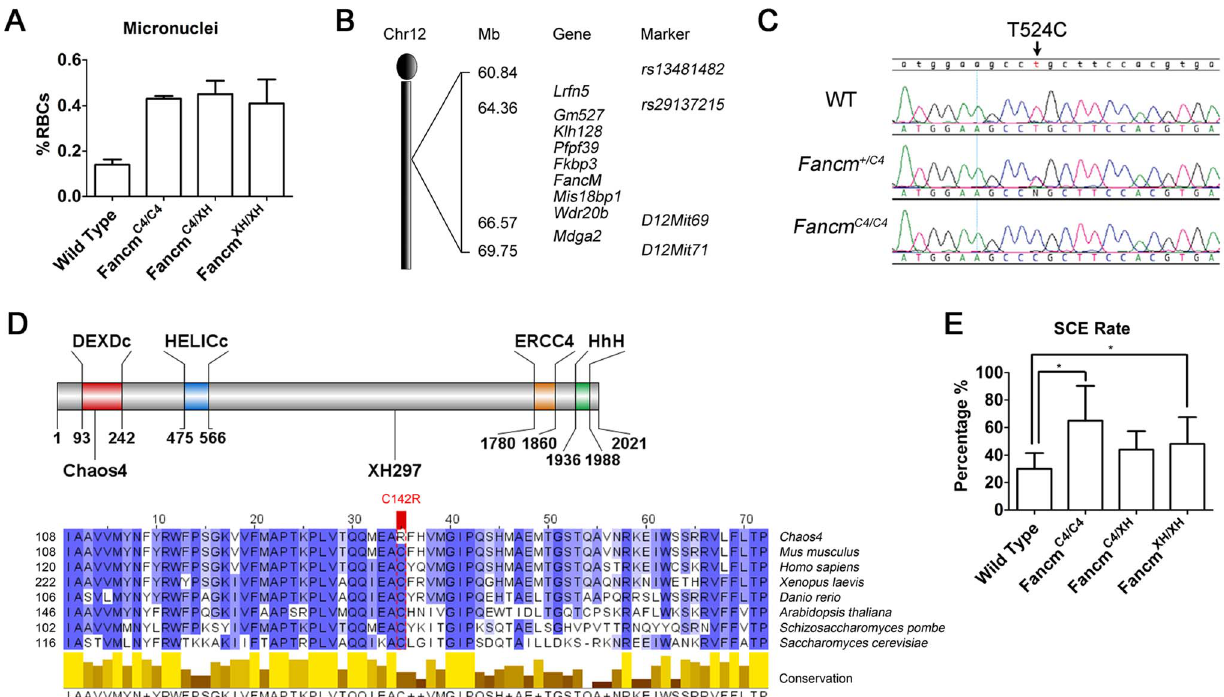
Figure 1. The Chaos4 allele is a point mutation in Fancm . (A) Flow cytometric analysis of erythrocytes to quantify red blood cells (RBC) with micronuclei. (B) Genetic mapping of Chaos4 to a 9-Mb region of chromosome 12 containing Fancm between rs13481482 and D12Mit71 . (C). Sequence traces showing the T524C transversion (arrows) identified in the Chaos4 allele of Fancm . (D) The Chaos4 point mutation is in the first exon, and the XH297 gene-trap is in the 14th exon. DEXDc, DEAD-like helicase domain; HELICc, Helicase superfamily c-terminal domain; ERCC4, ERCC4 endonuclease domain; HhH, Helix-hairpin-helix domain which interacts with FAAP24. Sequence alignment surrounding C142 is highly conserved from human to budding yeast. (E) SCE rates are significantly increased in Fancm C4/C4 MEFs (p ,